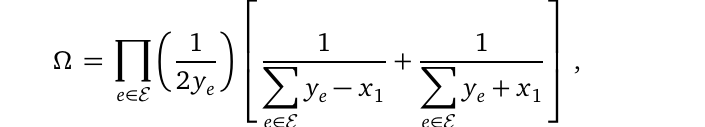
Figure 10: Intersections of the facets of the scattering facet S L -loop 2-site graph. There are two intersections. They are a codimension-2 and a codimension- n hyperplane, and are depicted in the first and second line, respec- e